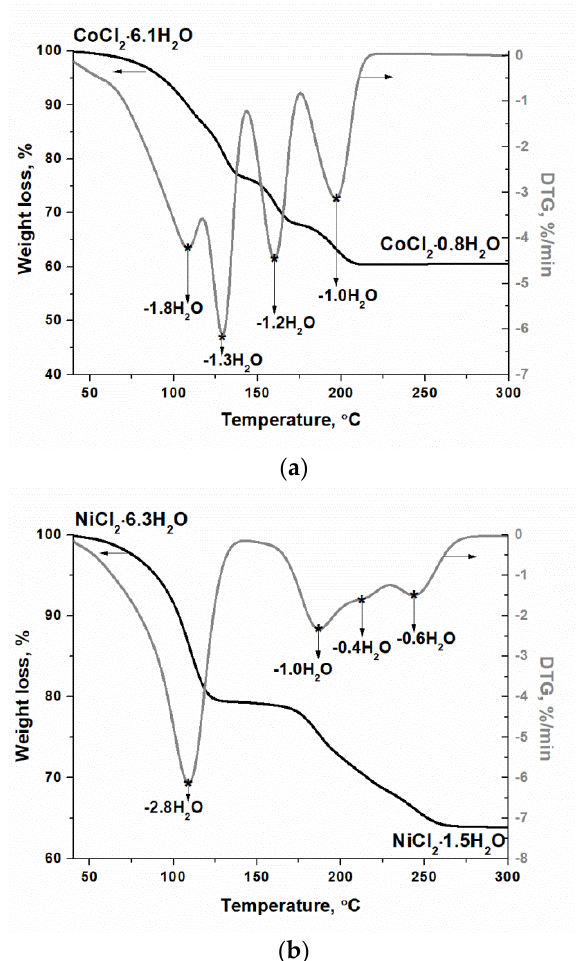
Figure 1. Thermal analysis results of water removal from initial salts: ( a ) cobalt chloride hydrate and ( b ) nickel chloride hydrate. Sample mass—100 mg. Feed rate of helium—30 cm 3 /min. Rate of heating—10 °С/min.